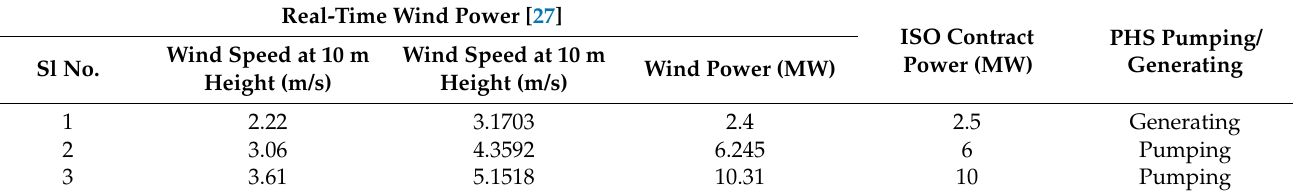
Table 5. WPHS operation based on the real-time wind speed data